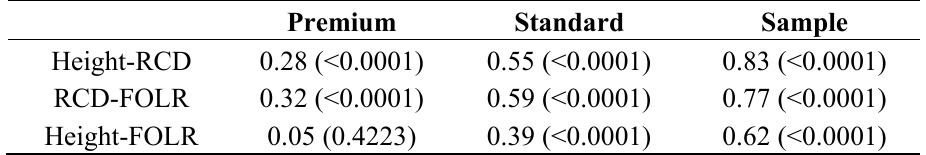
Table 2. Correlation values, with associated p -values, among height, root-collar diameter (RCD), and number of first-order lateral roots (FOLR) for two seedling grades and a random sample of 1–0 bare-root northern red oak nursery seedlings.